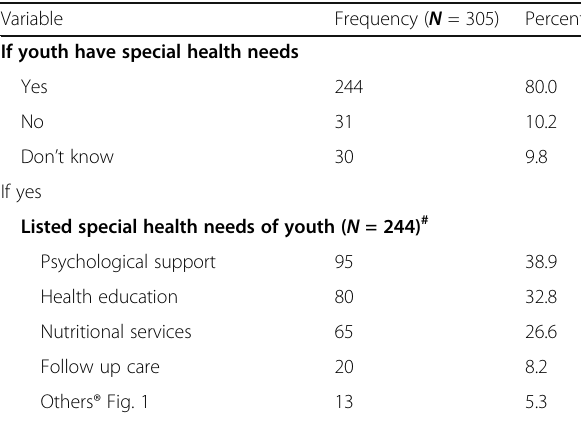
Table 1 Students ’ perception of youth health needs and